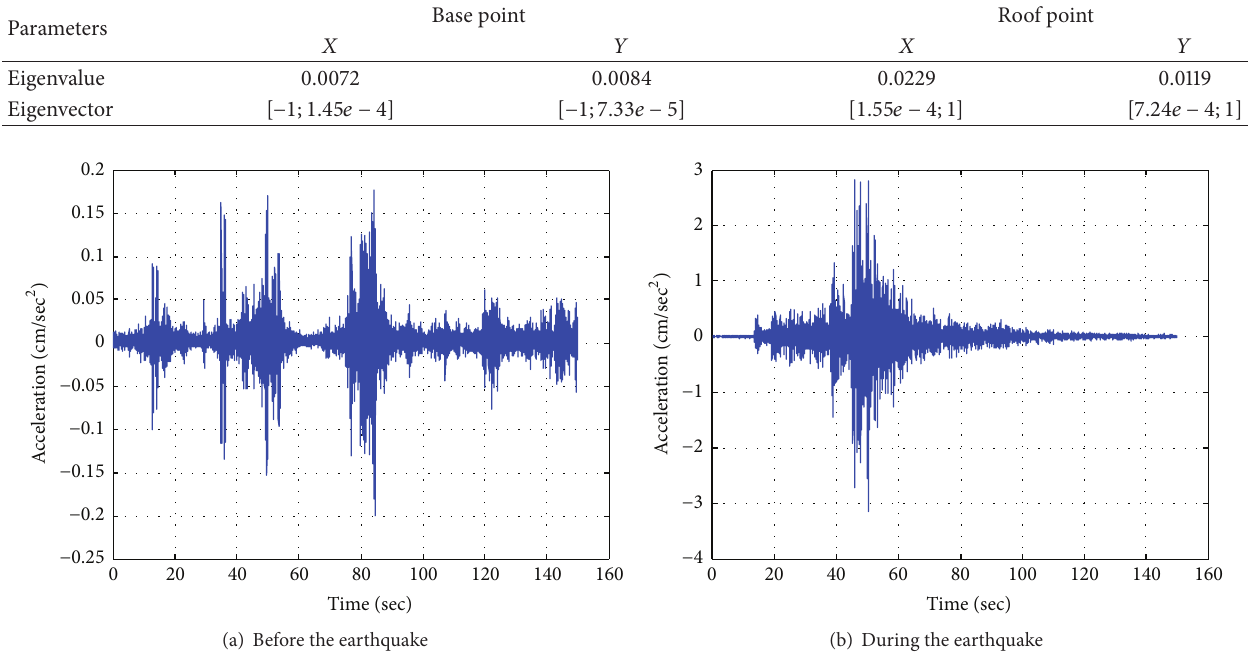
Figure 6: Acceleration response measurements at the ground point.